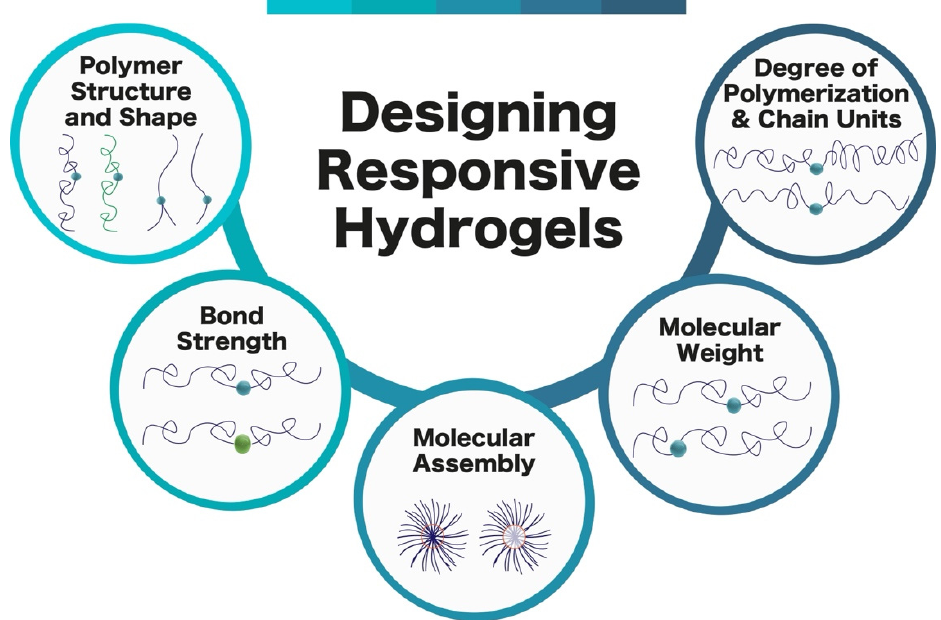
Figure 3. Overview of parameters influencing the design of ultrasound-responsive polymer- based